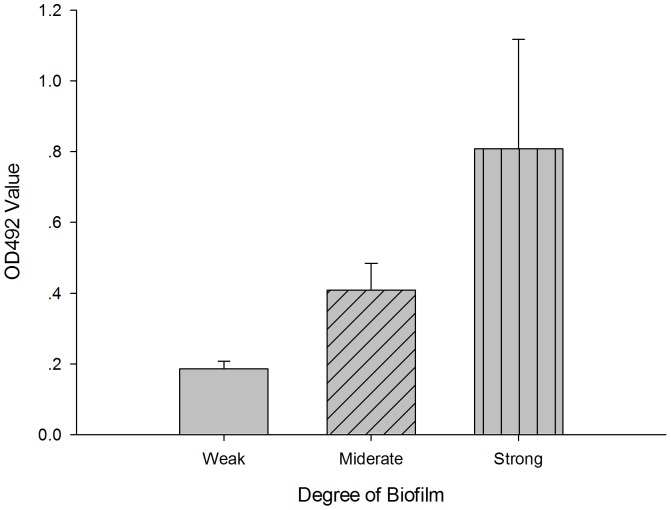
Histogram illustrating the ability of biofilm formation in tested isolates of S. maltophilia.